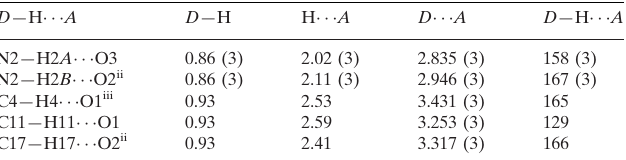
Hydrogen-bond geometry (A˚ , (cid:2)